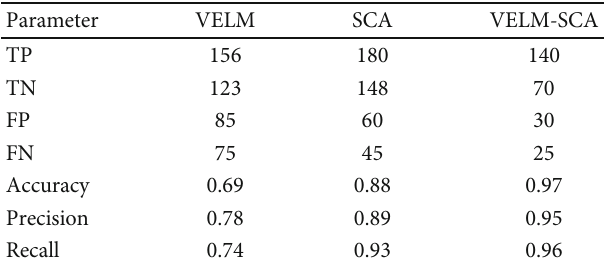
Table 3: Metric measures ’